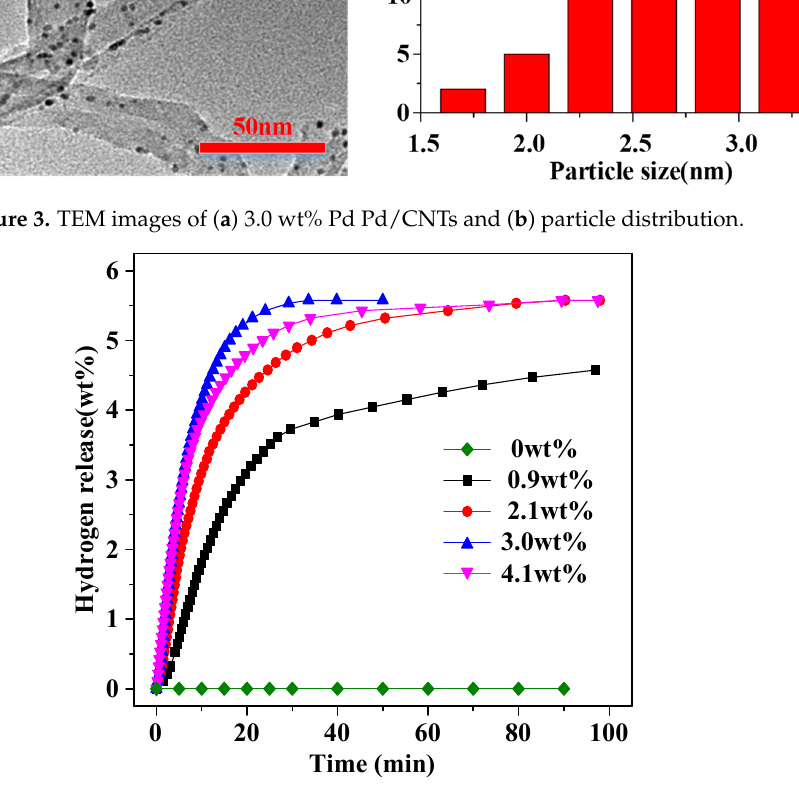
Figure 3. TEM images of ( a ) 3.0 wt% Pd Pd/CNTs and ( b ) particle distribution.